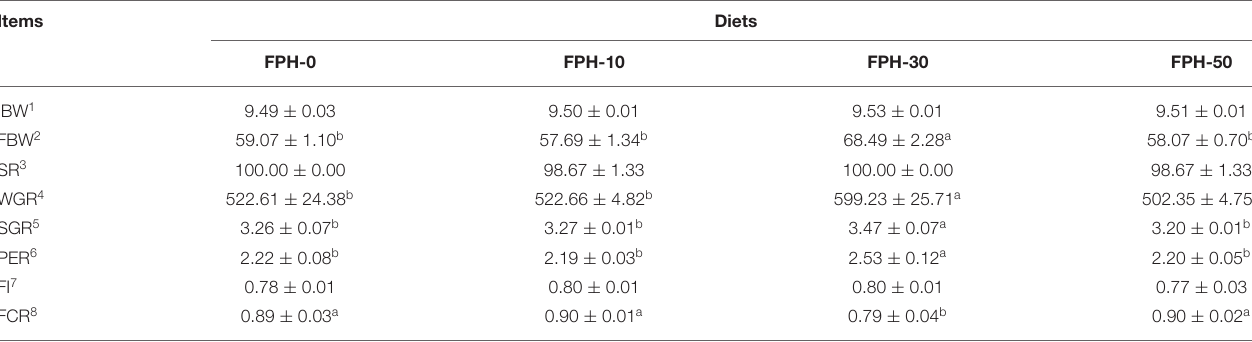
TABLE 5 | Growth performance and feed utilization of largemouth bass ( Micropterus salmoides ) fed the diets containing different supplementation levels of fish protein hydrolysate (FPH)*. Items